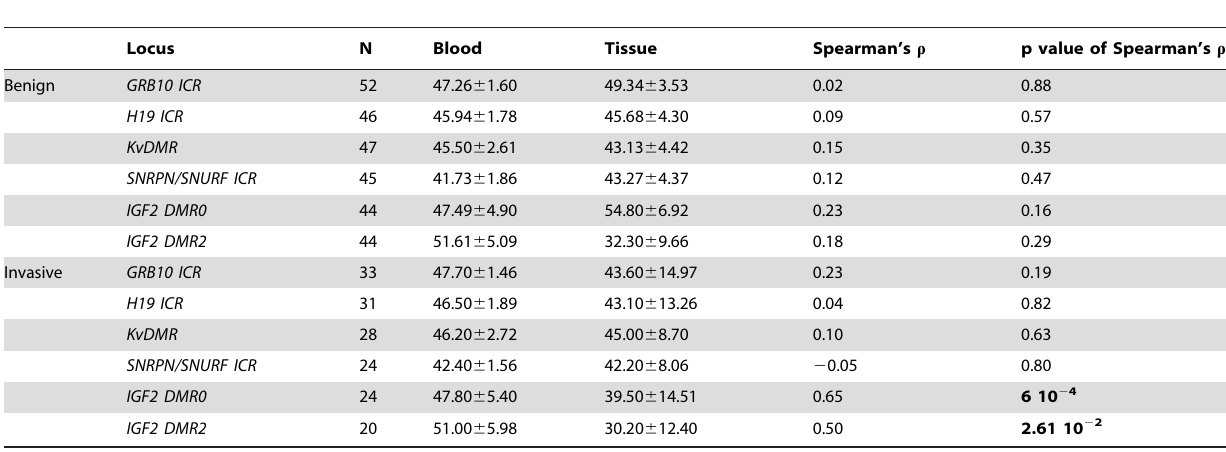
Table 2. Average percent-methylation in leukocyte and mammary tissue DNA from women with benign breast disease and invasive breast